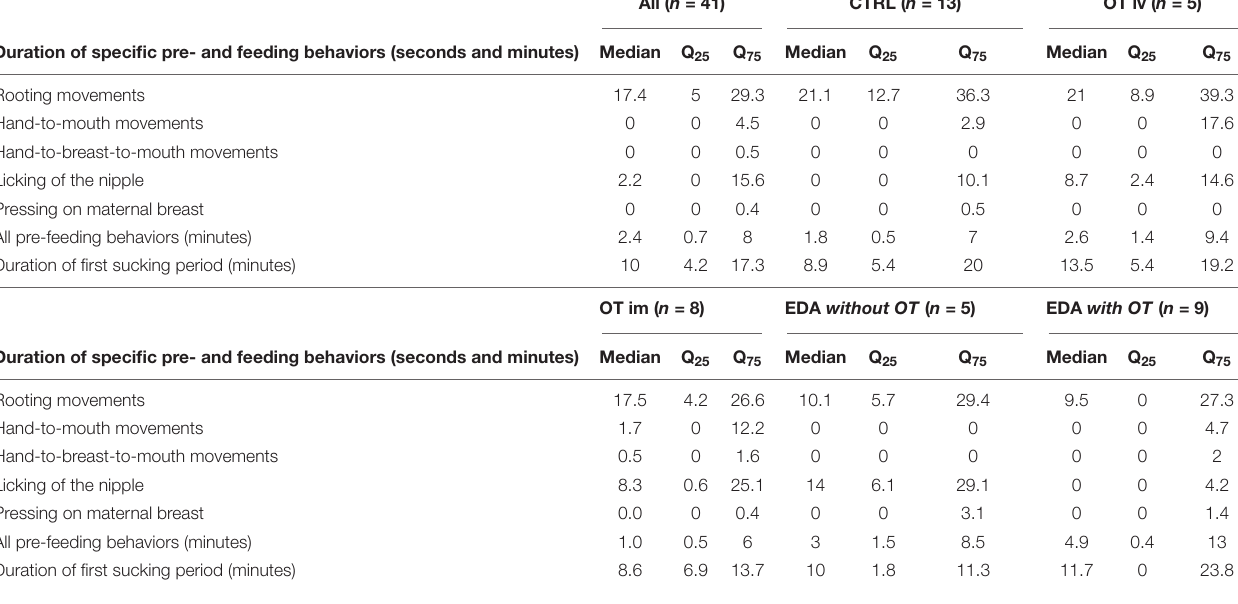
TABLE 4 | Duration (seconds) of pre-feeding behaviors during the last minute before the onset of breastfeeding and the duration of all pre-feeding behaviors (minutes) and of the first sucking period (minutes) (median, interquartile ranges Q 25 -Q 75 ), ( n = 41) in all infants and as a function of the medical interventions their mothers had received during childbirth.